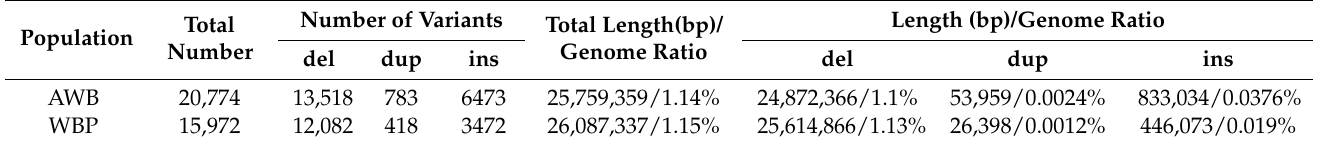
Table 1. The statistic of CNV in WBP and AWB.